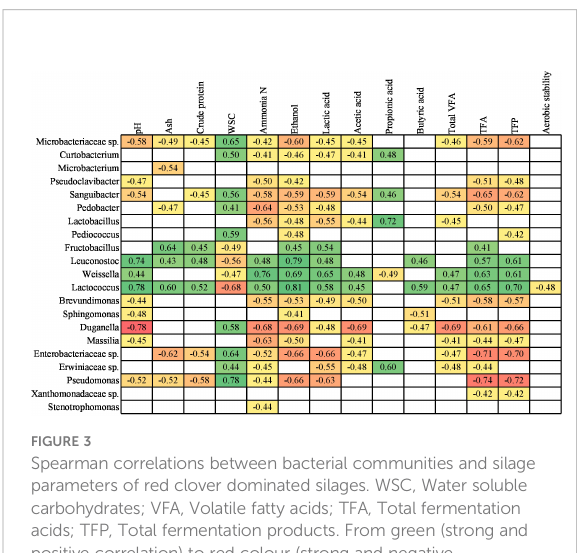
FIGURE 3 Spearman correlations between bacterial communities and silage parameters of red clover dominated silages. WSC, Water soluble carbohydrates; VFA, Volatile fatty acids; TFA, Total fermentation acids; TFP, Total fermentation products. From green (strong and positive correlation) to red colour (strong and negative correlation), while empty cells indicate non-signi fi cant